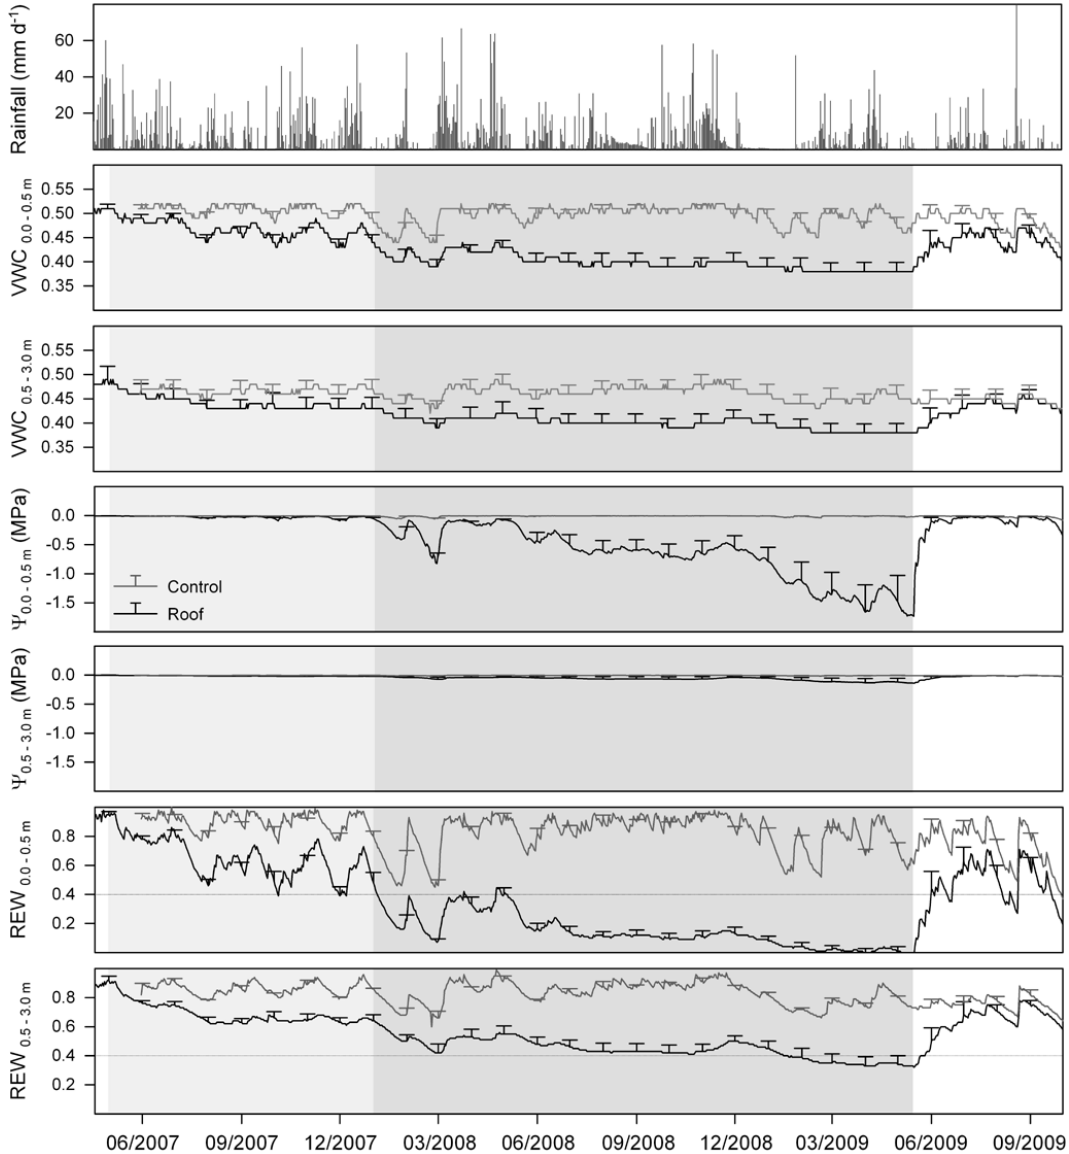
Fig. 2. Volumetric soil water content ( θ ), soil water potential ( 9 ) and relative extractable water (REW) of the control (grey line) and the drought (black line) plots during the 2-yr experimental period. Mean measuring depths are shown: upper layer (0.0–0.5m), lower layer (0.5–3.0m). Values are daily means ± 1SE. The light grey area marks the first period of the experiment when 50% of the roof was closed. The dark grey area indicates the second period of the experiment with a roof closure of 80%. The roof was opened again in May